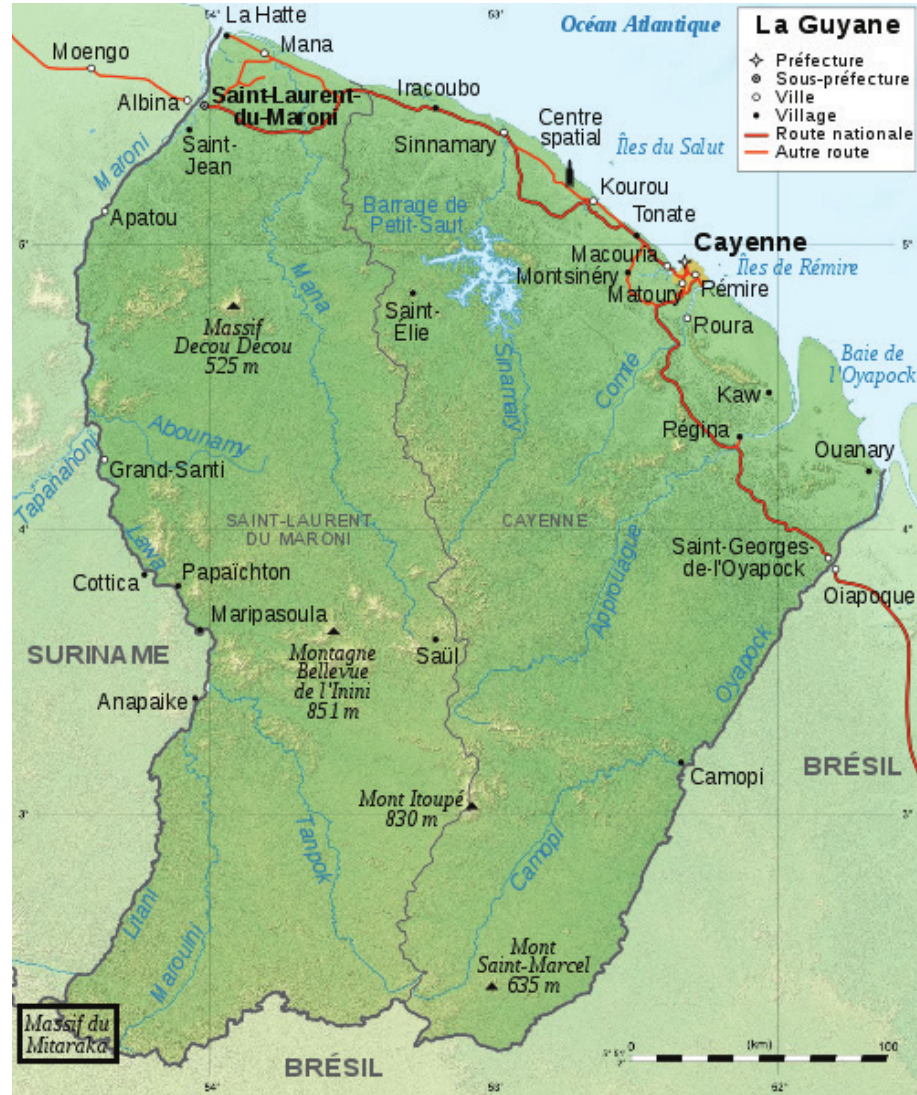
Figure 1. Map of French Guiana with indication of the investigated area (Mitaraka). Coscarón and Papavero (2009), Krolow and Henriques (2010), Turcatel et al. (2010), Krolow et al. (2015), and Henriques (2016). Doubtful country records are indicated by “?”. Next to previously published records, all records from the Mitaraka 2015 survey are included in the check list. Each of these records is represented by the sample code and the number and gender of the collected specimens. Detailed information on the samples is given in Appendix 1. First records for French Guiana are explicitly